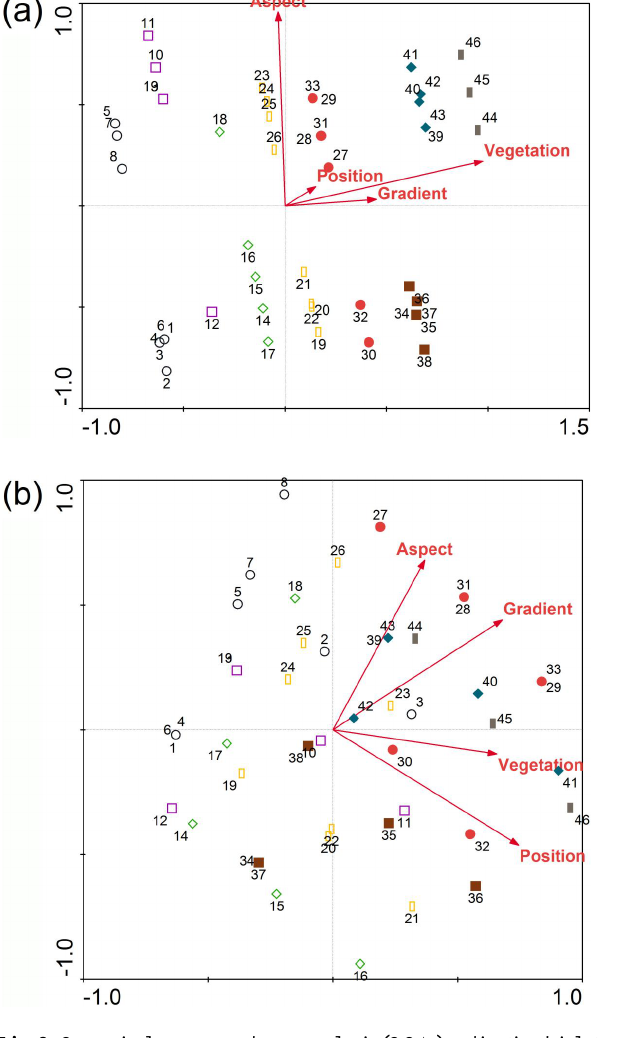
Fig. 8. Canonical correspondence analysis (CCA) ordination biplot showing the relationship between (a) shallow soil moisture content, (b) deep soil moisture content and environmental